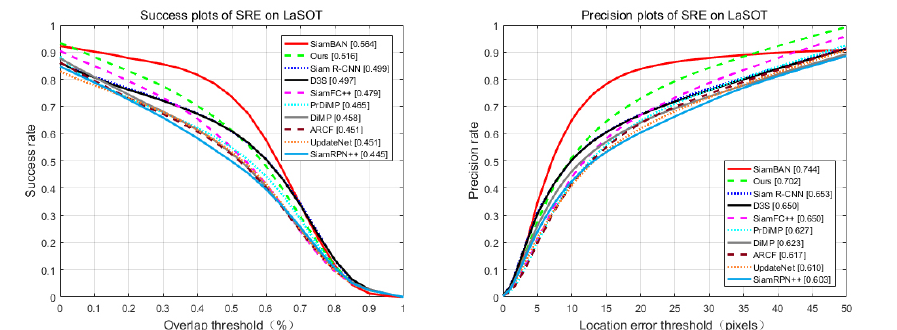
Figure 8. Success and precision plots on